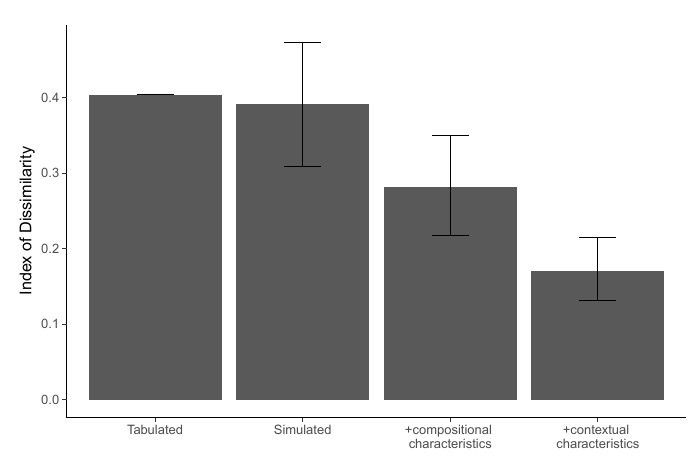
Ethnic residential segregation in Duisburg, calculated based on tabu- lated data and using multilevel binomial response